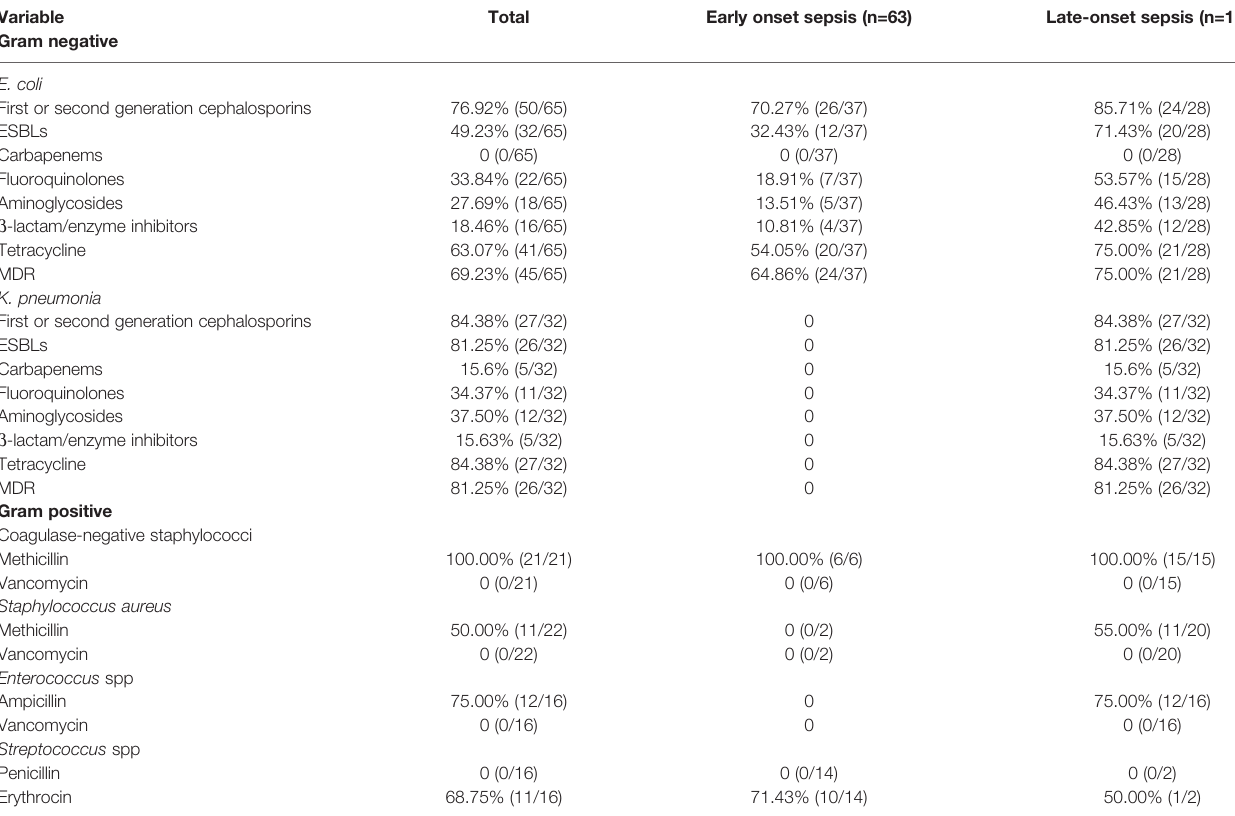
TABLE 5 | Pathogen and drug susceptibility of early onset sepsis and late-onset sepsis.